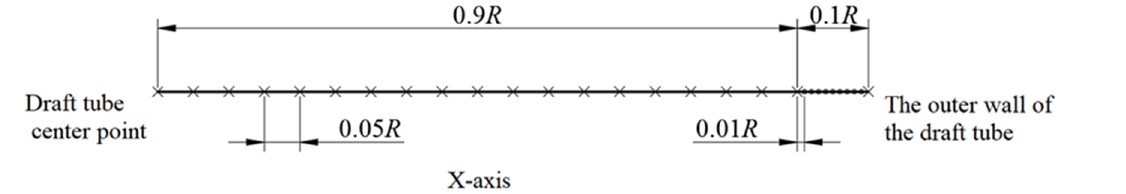
Figure 13. Test monitoring points in x-axis. Table 5. Test operating